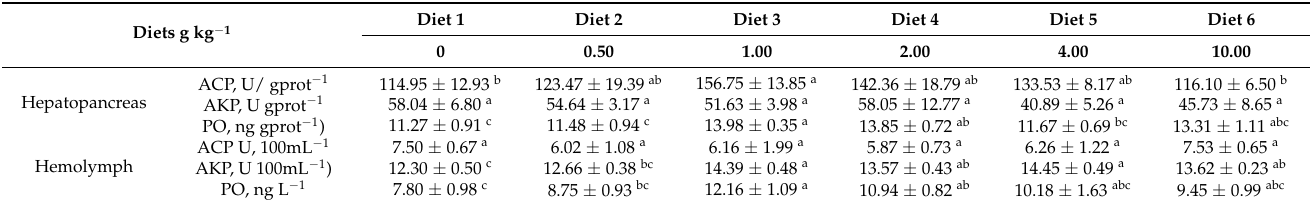
Table 9. Effects of ELE on immune parameters in hepatopancreas and hemolymph of Cherax quadricarinatus .